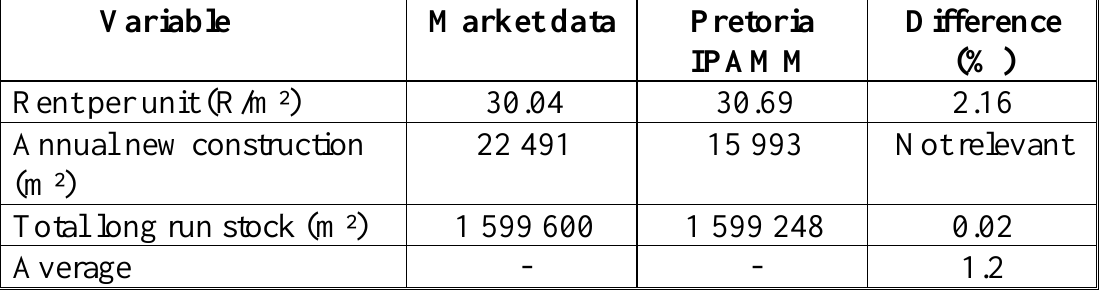
Table 3 Comparison of market data and Pretoria IPAMM